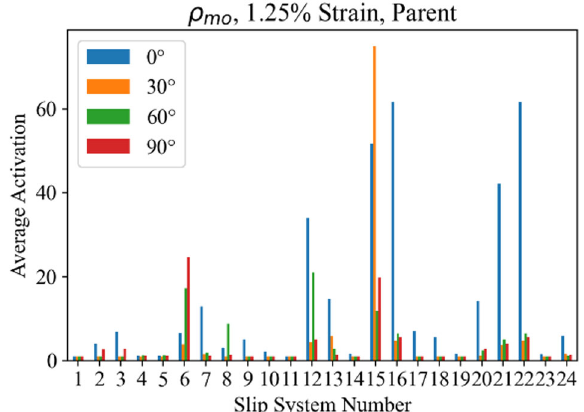
Fig. 21 Average mobile slip system activation for hydride material (fcc) at 1.25% nominal